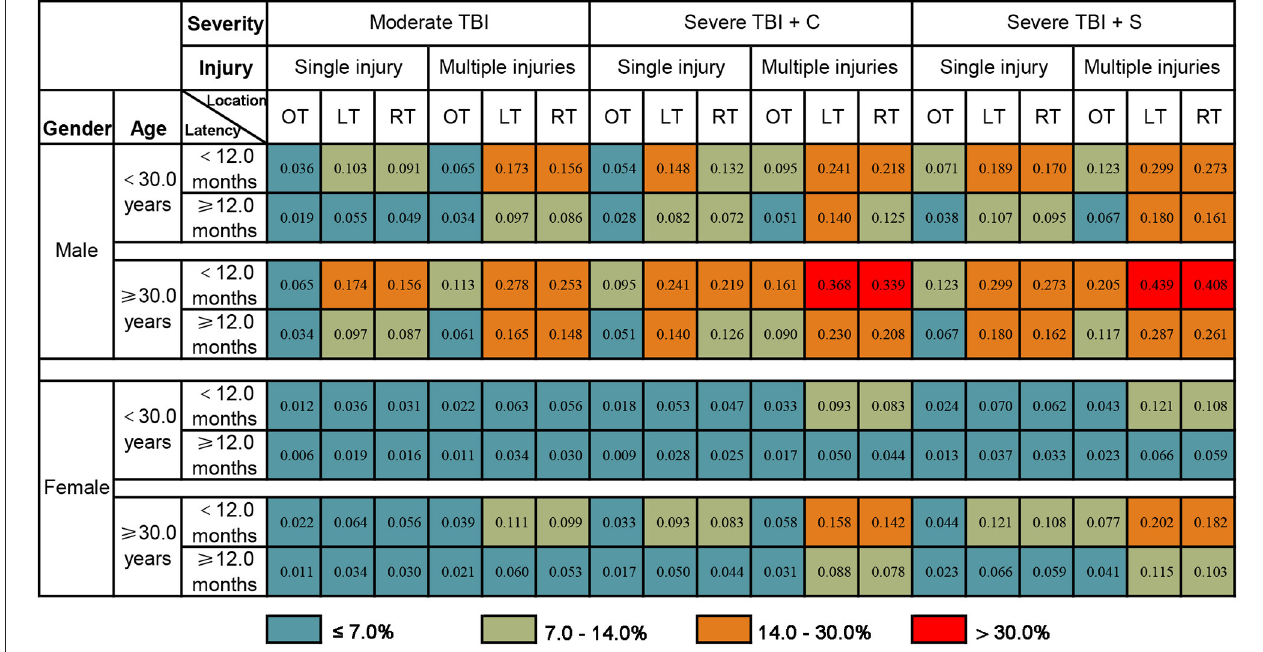
TABLE 4 | The number of patients at each risk level and the observed proportion of unfavorable 5-year global functional outcomes. Predicted probability Total (No.) Unfavorable